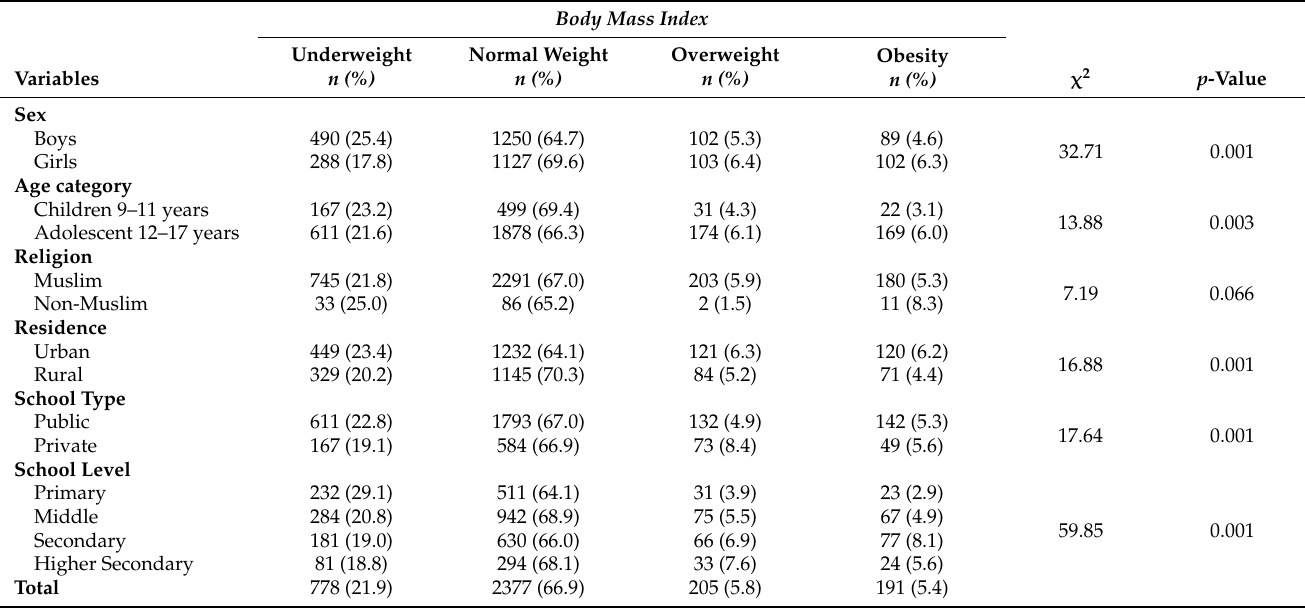
Table 3. Chi-square test (2-tailed) to compare the prevalence of body weight status with demographic parameters (sex, age, residence, religion, school type, and school level).